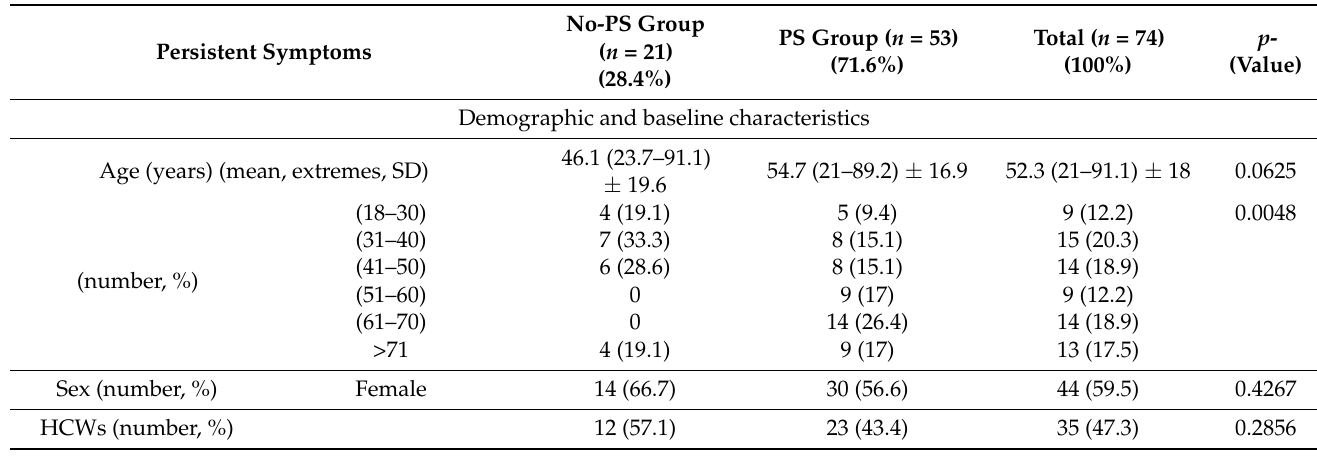
Figure 2. Proportion of persistent symptoms in the persistent symptom group ( n = 53) after SARS-CoV-2 infection. ENT (ear, nose and throat) symptoms: nasal obstruction, nasal pain, rhinorrhea, nasal dryness, sneezing, odynophagia, dysphonia. Cardiologic symptoms: chest pain, palpitations, lipothymia. Neurologic symptoms: headache, dizziness, drowsiness. Neuropathic pain: myalgias, paresthesias of the limbs. Psychiatric symptoms: depressive syndrome, memory impairment, attention deficit. Other symptoms: epicondylitis, erectile dysfunction. Table 1. Demographic and clinical characteristics in 74 COVID-19 patients with or without persistent symptoms after SARS-CoV-2 infection, Nord Franche-Comte Hospital,